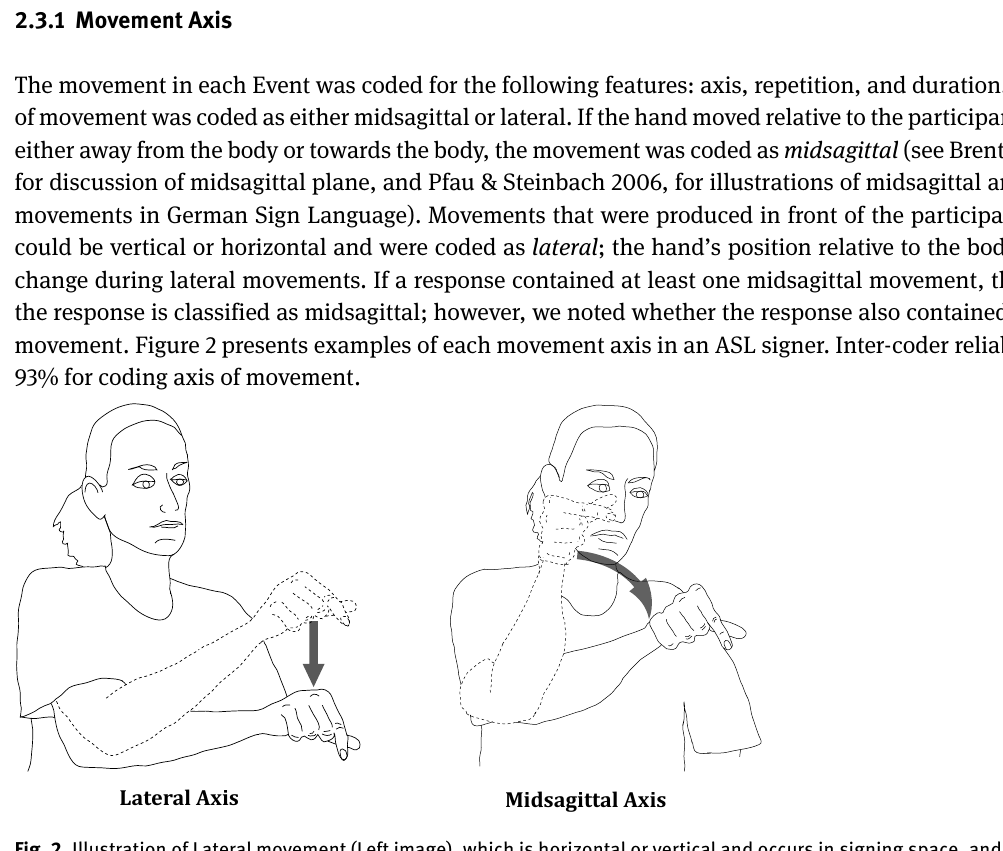
Fig. 2. Illustration of Lateral movement (Left image), which is horizontal or vertical and occurs in signing space, and Midsagit- tal movement (Right image), which is movement relative to the body, either towards the body or away from the